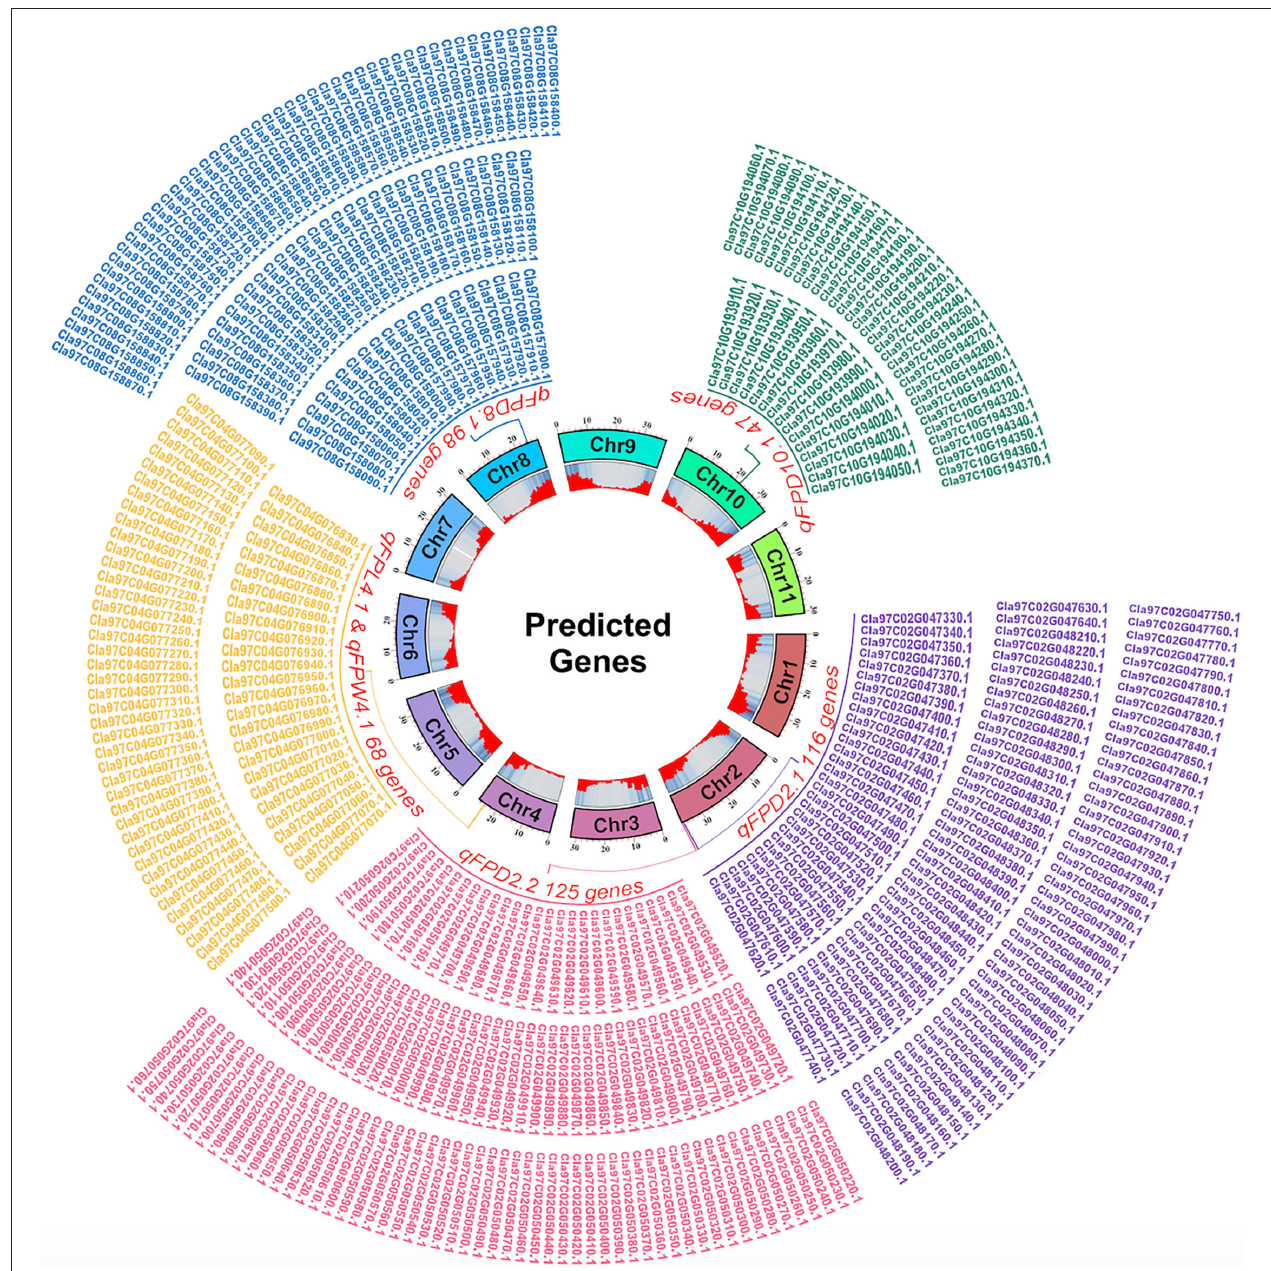
FIGURE 8 | A circle diagram of putative genes predicted in flanking QTL regions controlling FP traits in watermelon.